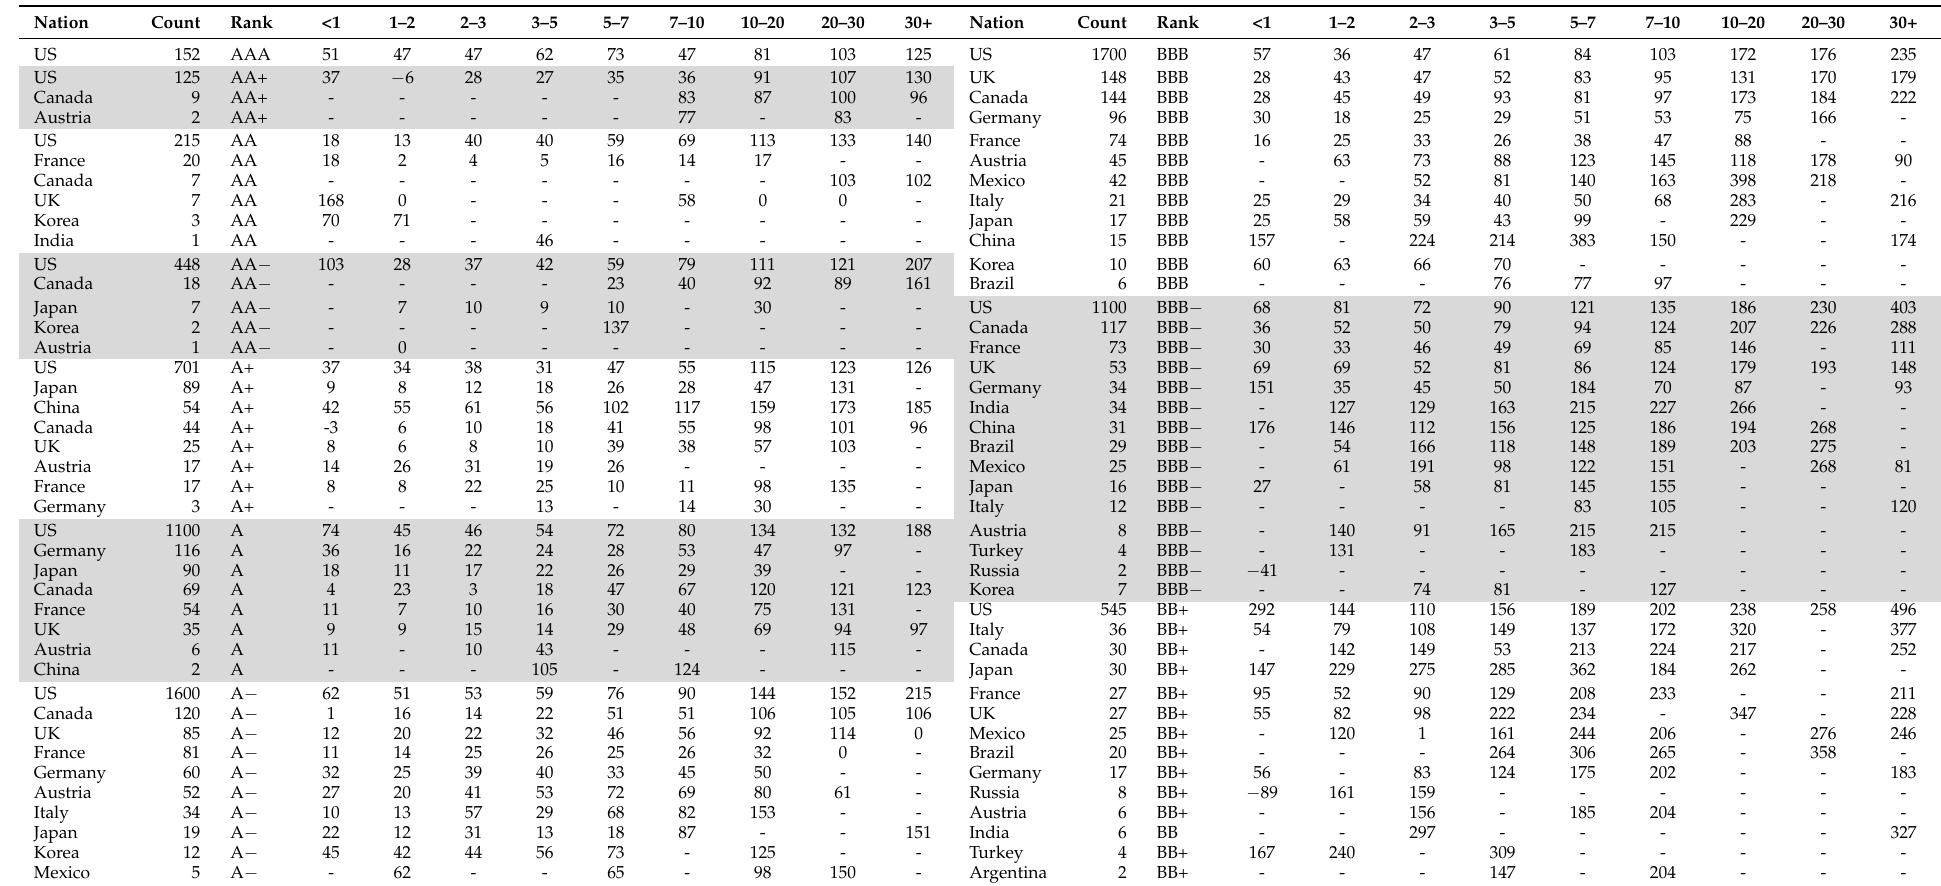
Table 8. The credit spreads in descending order. Each section’s first entry is the nation with the highest number of such bonds outstanding. Spreads are in basis points. No spread if it cannot be computed or no such bonds outstanding for the set term. (Date: 16 August